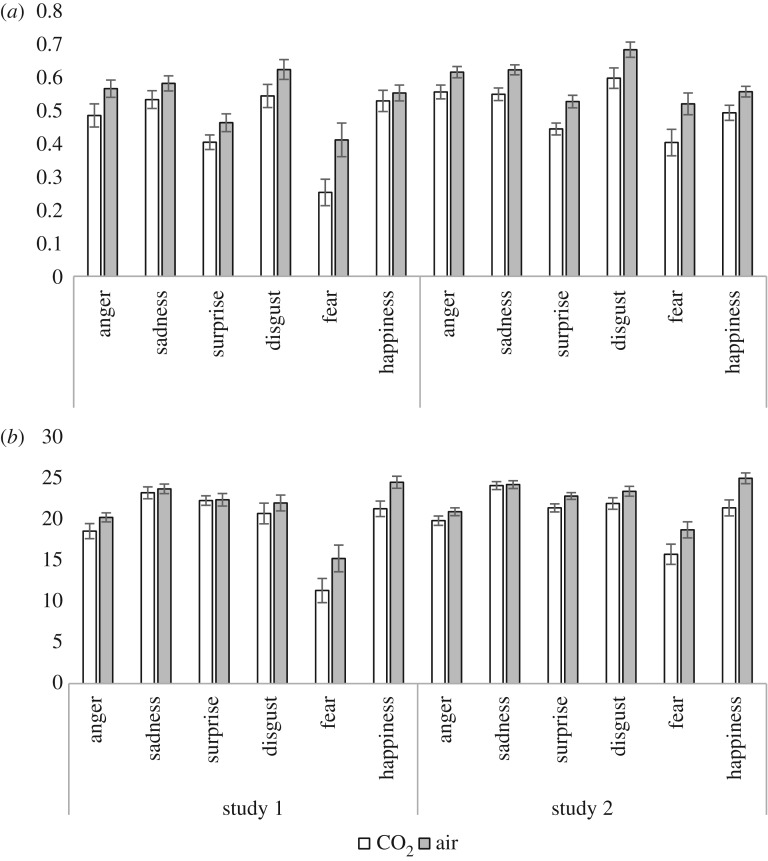
Mean (±s.e.) sensitivity (unbiased hit rate; a) and recognition accuracy (hits; b) for all six primary emotional expressions in study 1 (left) and study 2 (right).